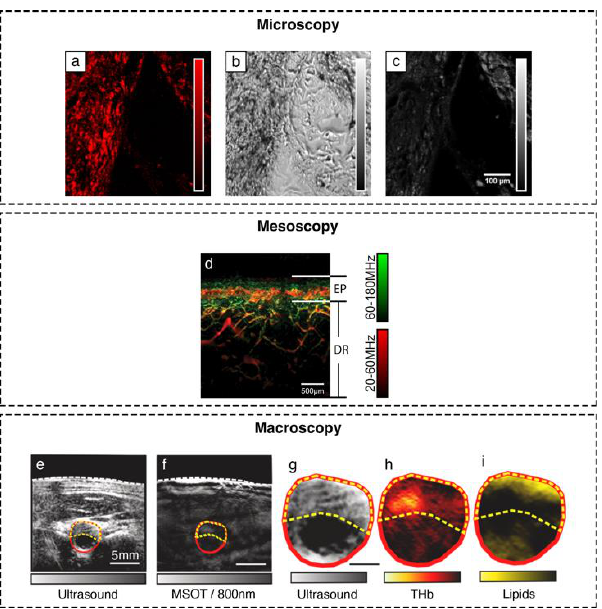
Figure 1. Optoacoustic principle and imaging configurations. Above , the optoacoustic effect, in which light absorbed by chromophores in tissue results in emission of ultrasound. Below , categorization of optoacoustic imaging configurations into microscopic, mesoscopic, and macroscopic, with the corresponding tissue penetration depth limits and resolution orders of magnitude, as reported in relevant reviews [8,9,23].